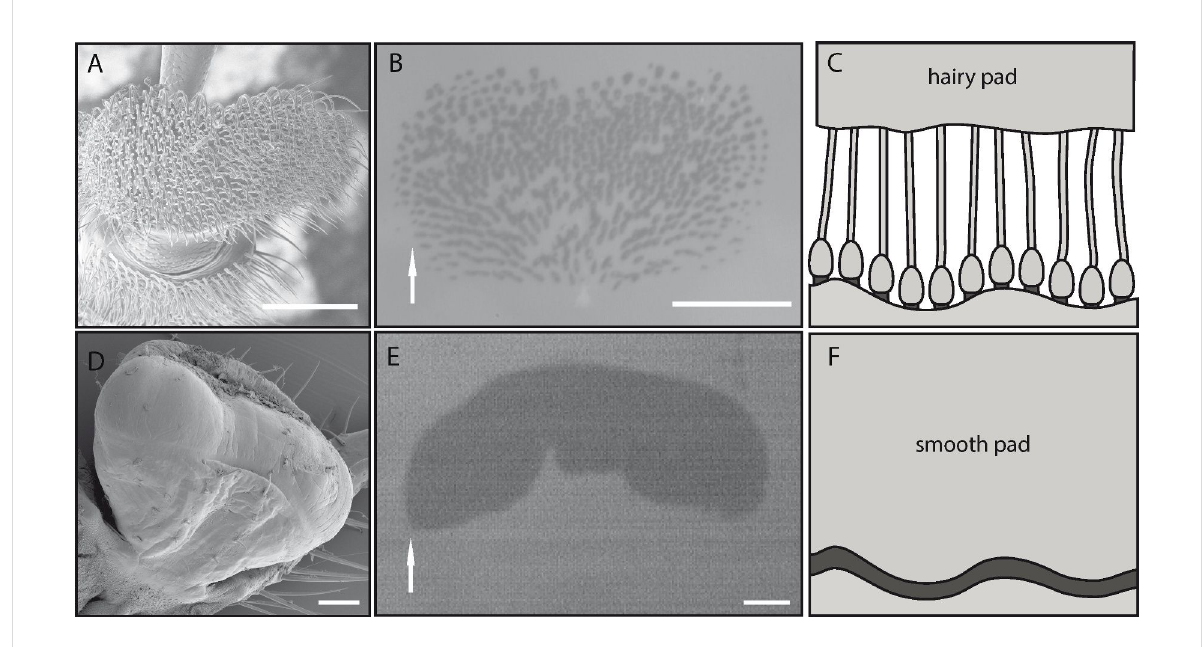
Figure 1: Adhesive pad morphology of a male dock beetle ( Gastrophysa viridula , A) and an Indian stick insect ( Carausius morosus , D). Epi-illumina- tion can be used to visualise the contact area of the adhesive pad in contact with glass (B, E). Arrows indicate distal direction. Subfigures C and F show a schematic view of the close contact of the hairy and smooth pads to a rough substrate. Note that in both cases the contact zone is mediated by an adhesive fluid (dark). Images A, B, D and E adapted with kind permission of [16]. Copyright (2008) The Company of Biologists Ltd. All scale bars represent 100 μ